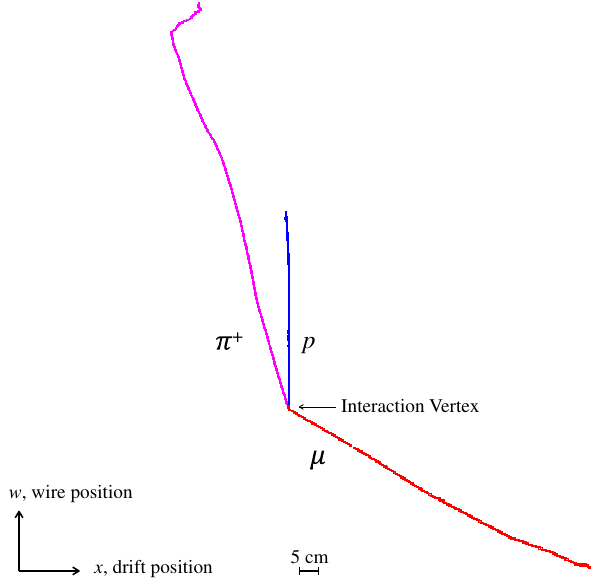
Fig. 14 The reconstruction of a simulated 1.1-GeV CC ν μ interaction with resonant charged-pion production. Target particles for the recon- struction are the muon, proton and charged pion